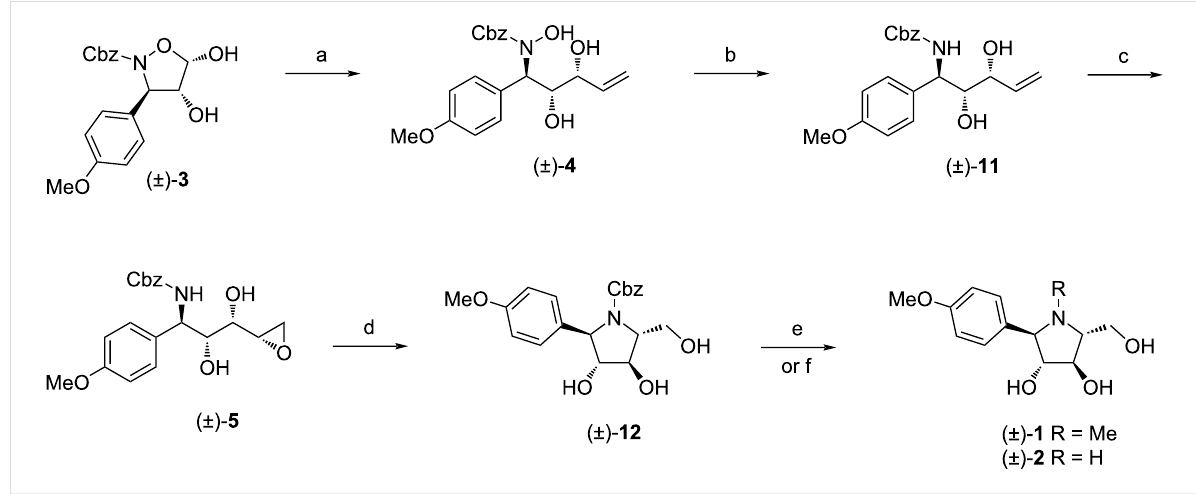
Scheme 3: Synthesis of final pyrrolidines (±)- 1 and (±)- 2 . Reagents and conditions: (a) vinyl-MgBr, CeCl 3 , THF, 0 °C to rt, 16 h, 73%; (b) Zn dust, AcOH, 40 °C, 24 h, 85%; (c) 12WO 3 ·H 3 PO 4 ×H 2 O, H 2 O 2 (35 wt % in H 2 O), pyridine, ethyl acetate, rt, 48 h, 70%; (d) BF 3 ·OEt 2 , CH 2 Cl 2 , 0 °C, 15 min,